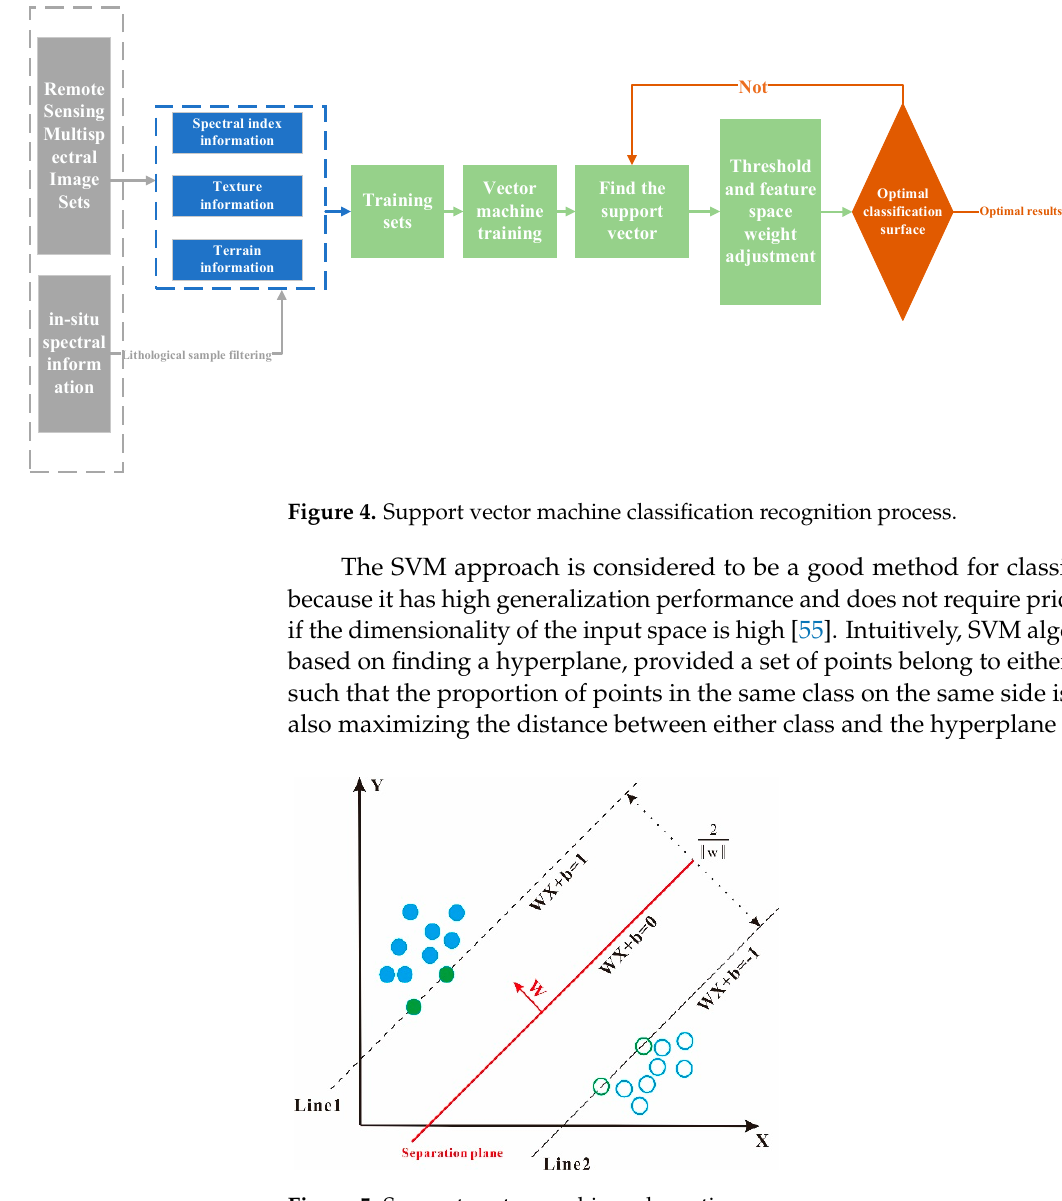
Figure 5. Support vector machine schematic.